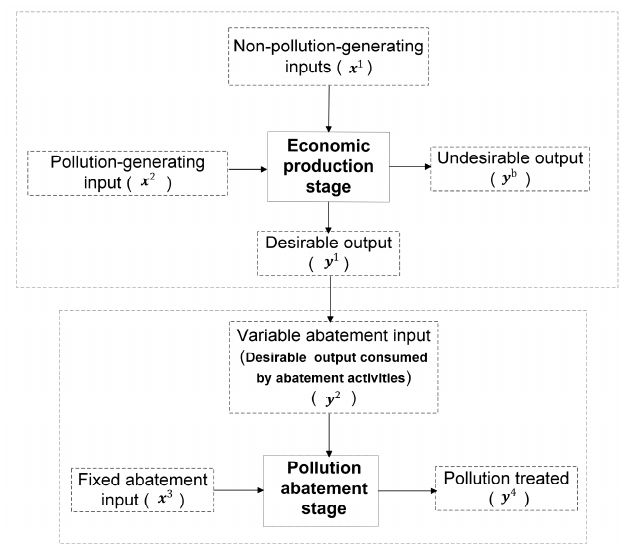
Figure 2. The production system with a two-stage structure.